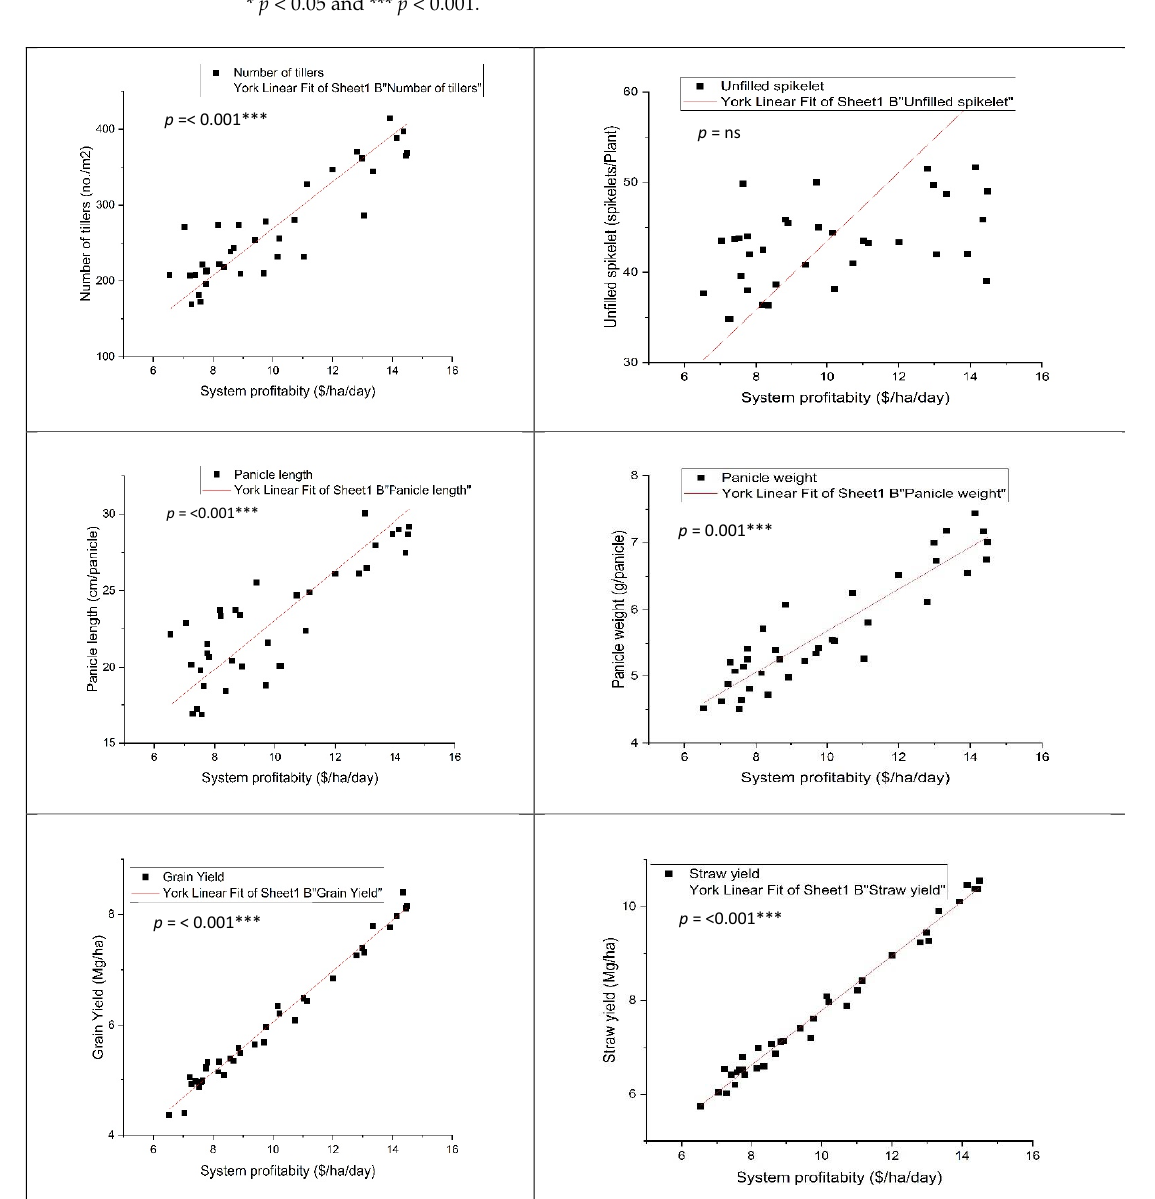
Figure 2. Relationship between system profitability and yield attributes and yield of unpuddled transplanted rice. Note: *** represent significant difference at the <0.001 levels.